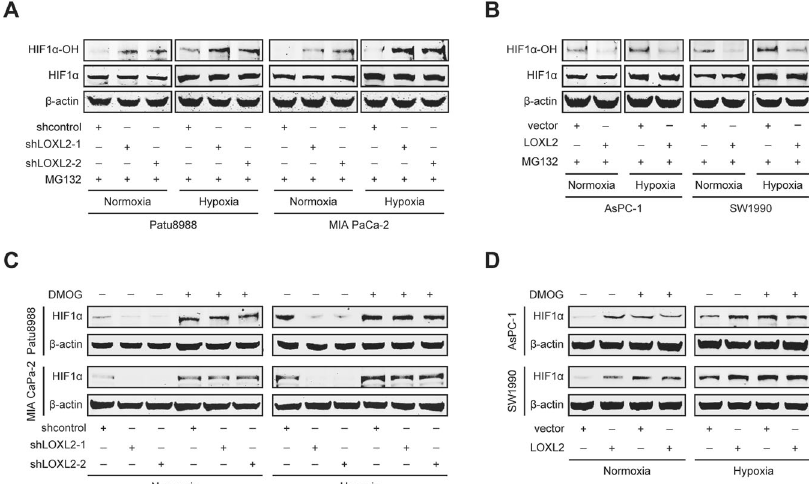
Fig. 7 LOXL2 inhibits prolyl hydroxylase (PHD)-dependent hydroxylation of HIF1 α . A Western blotting showing amounts of hydroxylated HIF1 α (HIF1 α -OH) and HIF1 α in LOXL2 knockdown and control cells treated with 10 μ M MG132 for 6 h under normoxic and hypoxic conditions. B Western blotting showing amounts of HIF1 α -OH and HIF1 α in LOXL2-overexpressing and vector control cells treated with 10 μ M MG132 for 6 h under normoxic and hypoxic conditions. C Western blotting showing HIF1 α expression in LOXL2 knockdown and control cells treated with or without 1 mM dimethyloxalylglycine (DMOG) for 24 h under normoxic and hypoxic conditions. D Western blotting showing HIF1 α expression in LOXL2-overexpressing and vector control cells treated with or without 1 mM DMOG for 24 h under normoxic and hypoxic